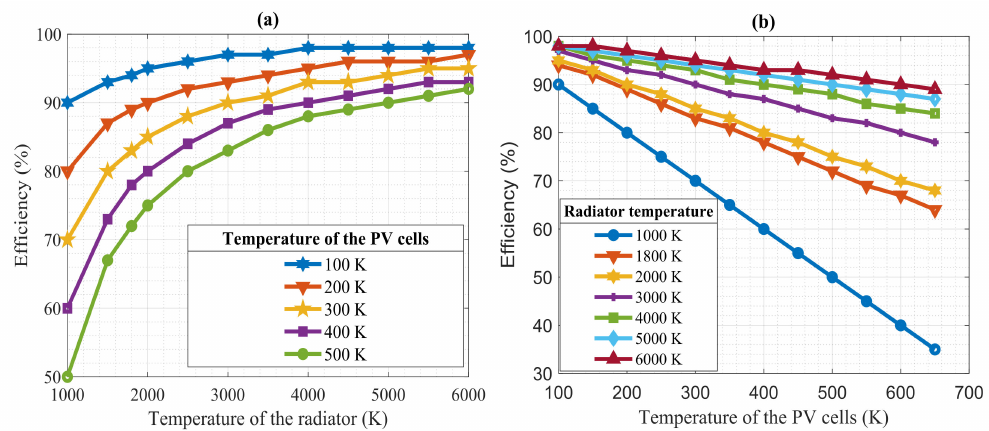
Figure 10. Thermal e ffi ciency of the TPV system: ( a ) E ff ects of increasing the radiator temperature on e ffi ciency; ( b ) e ff ects of increasing the PV cells temperature on e ffi